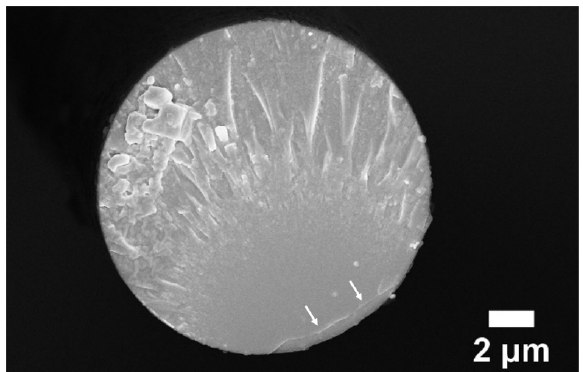
Figure 8. SEM micrograph of the cross-section of an artificially notched basalt fibre after tensile test (white arrows indicate the location of the artificial notch).